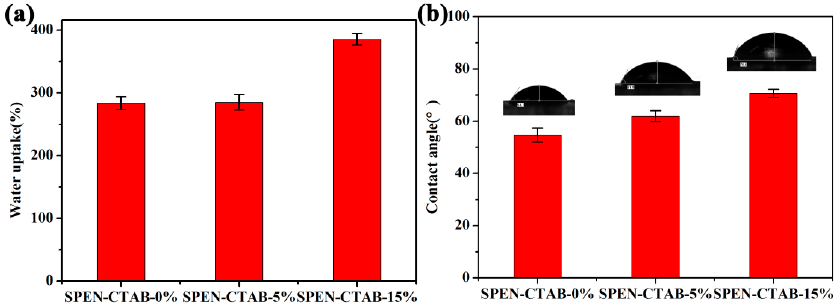
Figure 3. The water uptake ( a ) and contact angle ( b ) of SPEN-CTAB-0%, SPEN-CTAB-5% and SPEN-CTAB-15%.